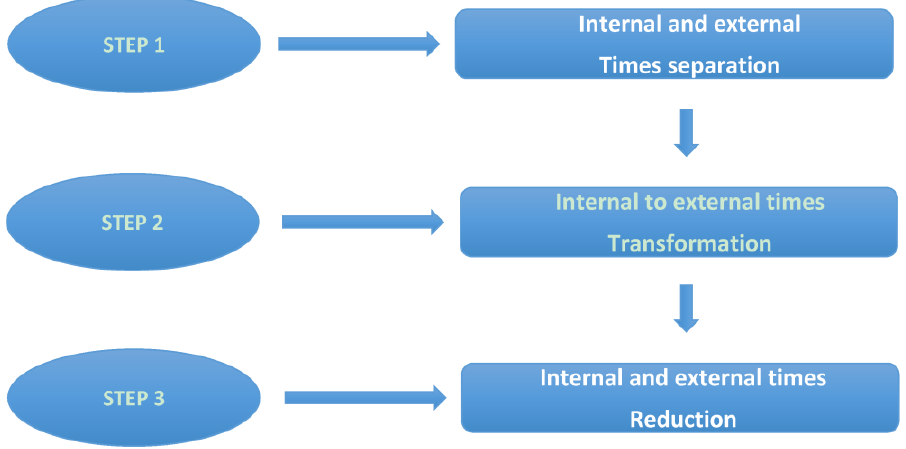
Figure 7. SMED application procedure.